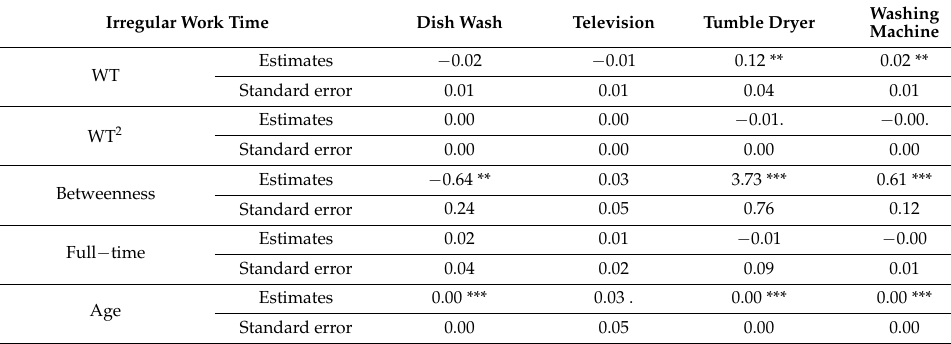
Table 7. Marginal effect of irregular work time on energy